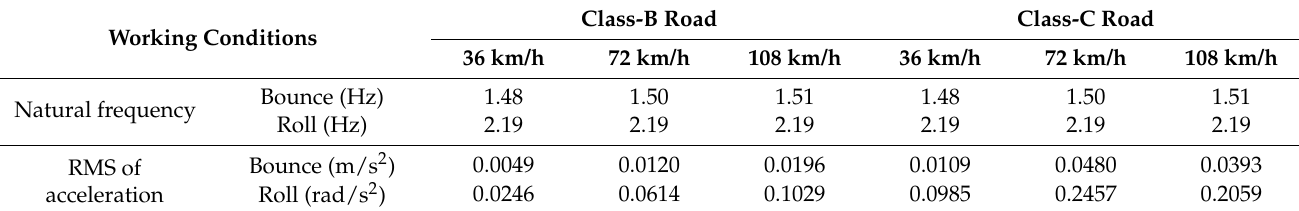
Table 5. The natural frequency and RMS acceleration response of the HIIRS-equipped vehicle.